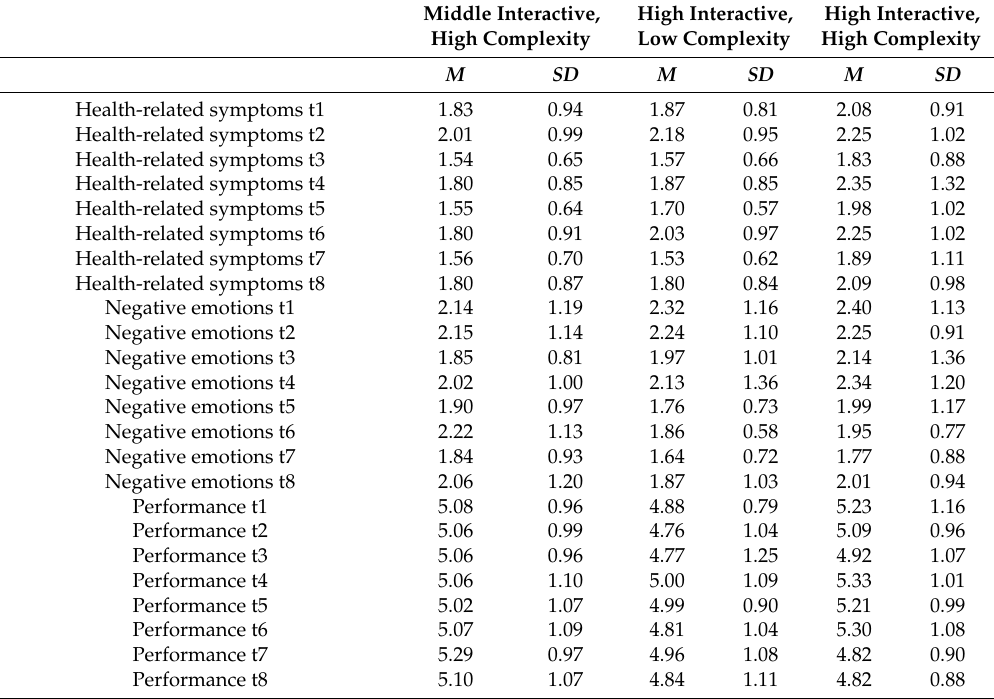
Middle Interactive, High Complexity